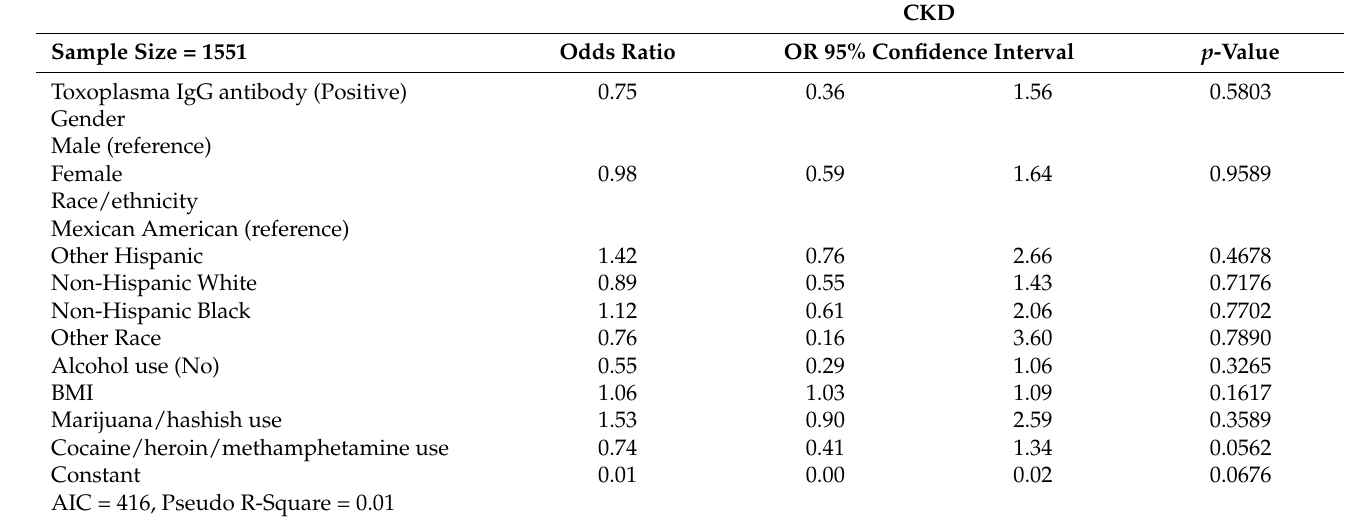
Table 8. Binomial Logistic regression model for CKD status on T. gondii IgG antibody (posi- tive/negative) adjusted for the demographic factors (except age) and other covariates, including drug use.